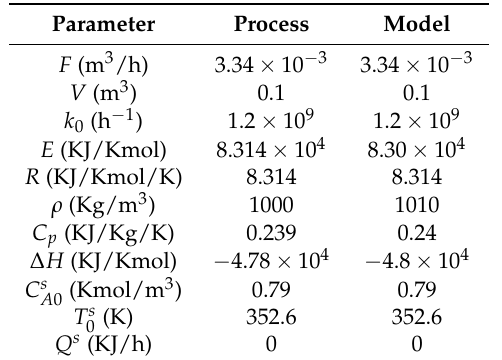
Table 1. Process and model parameter values for the continuous stirred tank reactor (CSTR) example in Equation